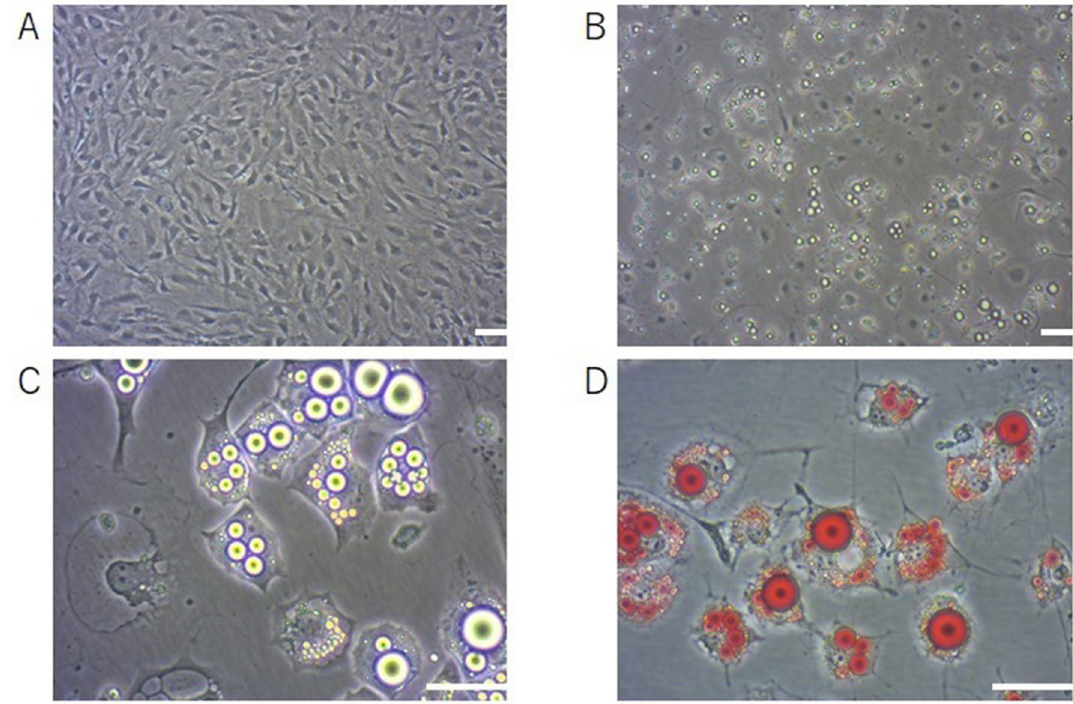
Figure 1. Differentiation of adipocytes from OP9 cells. ( A – D ) OP9 cells were cultured ( A ), and adipocytes differentiated from them ( B , C ) were stained with Oil Red O. Lipid droplets are highlighted ( D ). Scale bars, 100 µm ( A , B ) and 50 µm ( C , D